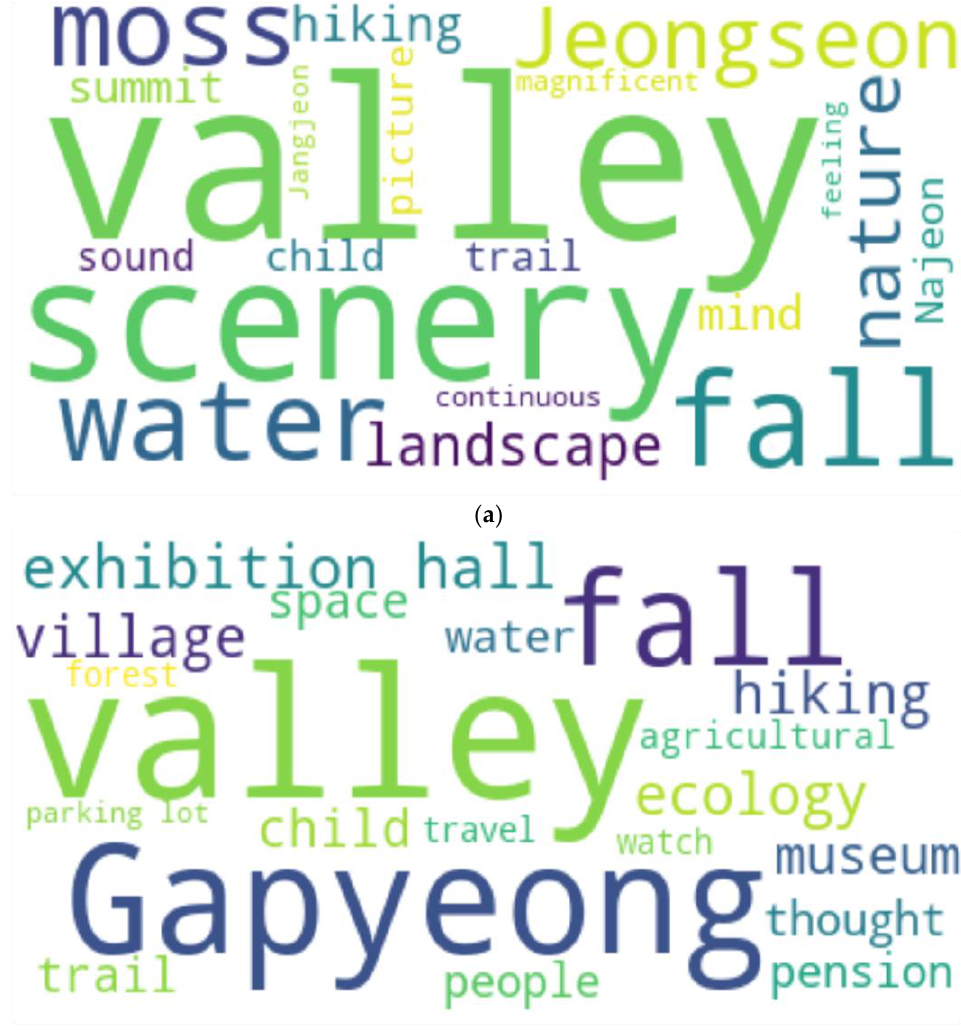
Figure 6. Word cloud results of ( a ) Gariwangsan and ( b ) Yeoninsan.